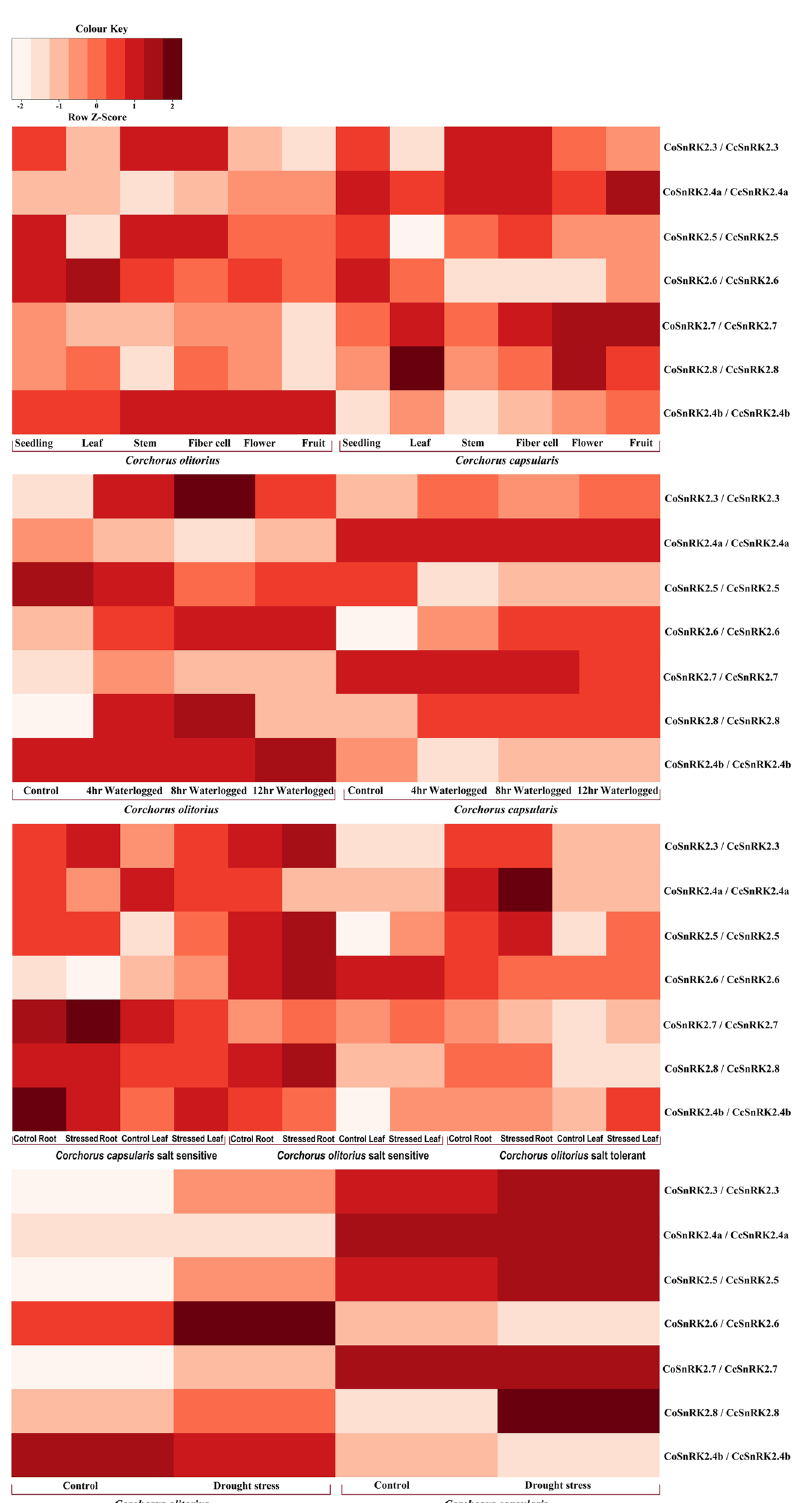
Fig. 7 Expression profiling of CoSnRK2 and CcSnRK2 genes in six different tissues and against waterlogged stress, salt stress, and drought stress. The log2-transformed FPKM (fragments per kilobase of exon model per million mapped reads) added by a pseudo-count of 1 value was used for heat map